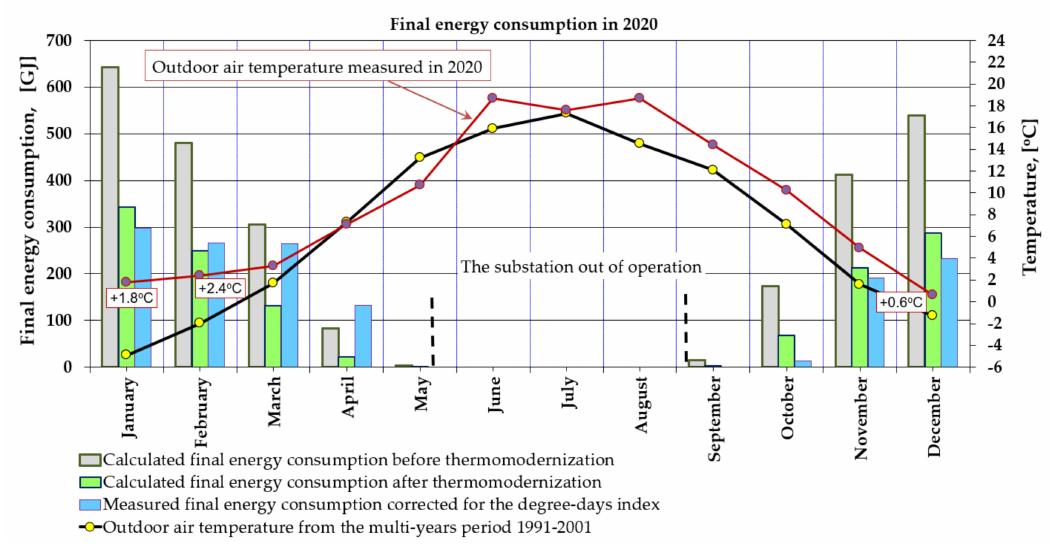
Figure 14. Final heat energy consumed for heating and ventilation needs of building A in 2020 and final energy corrected by the energy index of degree days ∂ together with the monthly outdoor air temperatures recorded in 2020 and the average outdoor air temperature for the multi-year period for the Bialystok weather